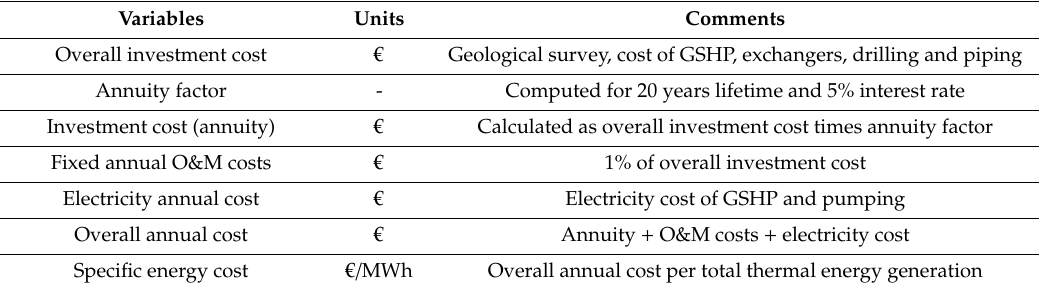
Table 3. Variables for economic evaluation.